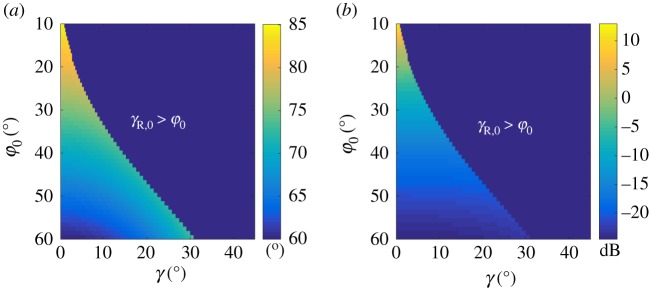
(a) Solution to equation (A 12) in the form θ(γ, φ0) in the case m = 0, n = 2; (b) relative side lobe amplitude (expression A 13) at r = λ as a function of azimuth γ in the generalized image domain and half angular aperture φ0. (Online version in colour.)